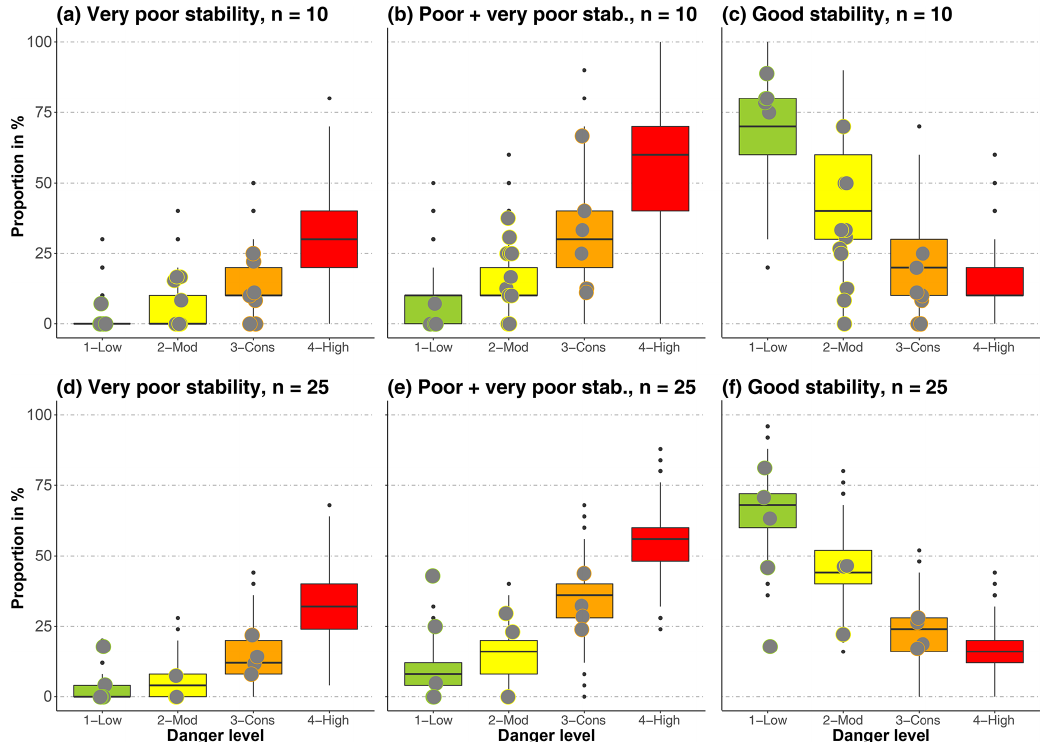
Figure 9. Comparison of observed (points, N = 41) and bootstrap-sampled distributions (boxes) for the proportion of very poor (a, d) , very poor and poor combined (b, e) , and good (c, f) stability tests, for two settings of the number n of tests drawn. When 7 to 15 RB tests were observed on the same day and within the same region, these are shown together with sampled distributions using n = 10 (a–c) . When more than 16 tests were collected, these are shown together with sampled distributions using n = 25 (d–f)